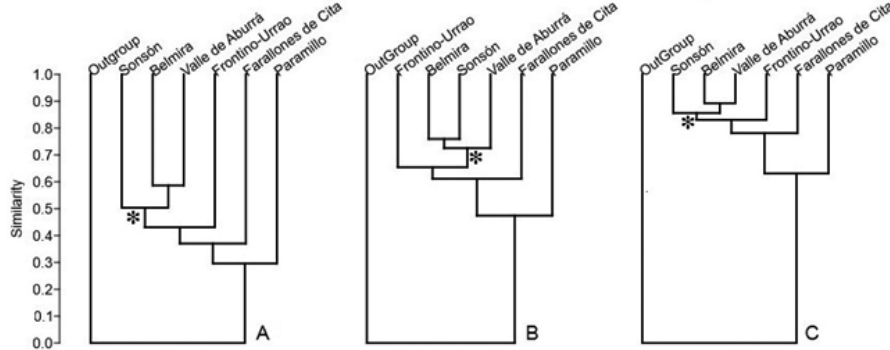
Figure 2. Similarity dendrograms for the six páramo complexes in Antioquia using Angiosperm com- position A Built using species composition B genera composition, and C family composition. Asterisk* denotes the node for páramos of Central